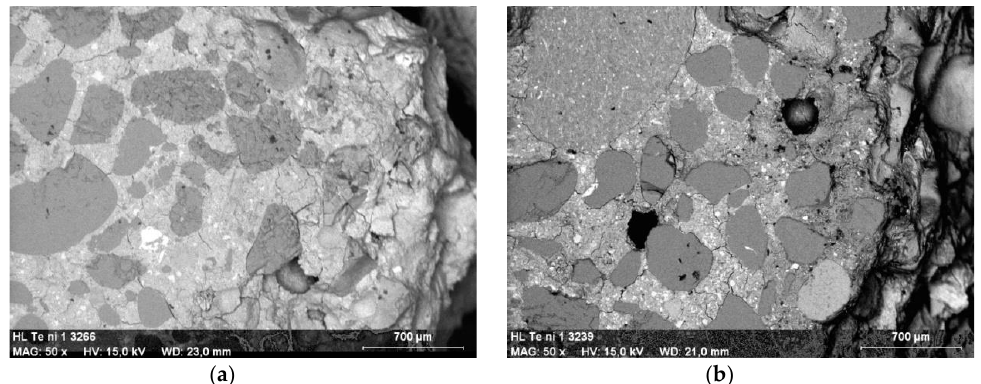
Figure 8. Polymer-cement mortar, p/c = 0.05, stored in 5% MgSO 4 solution: ( a ) after 12 months; ( b ) after 42 months.